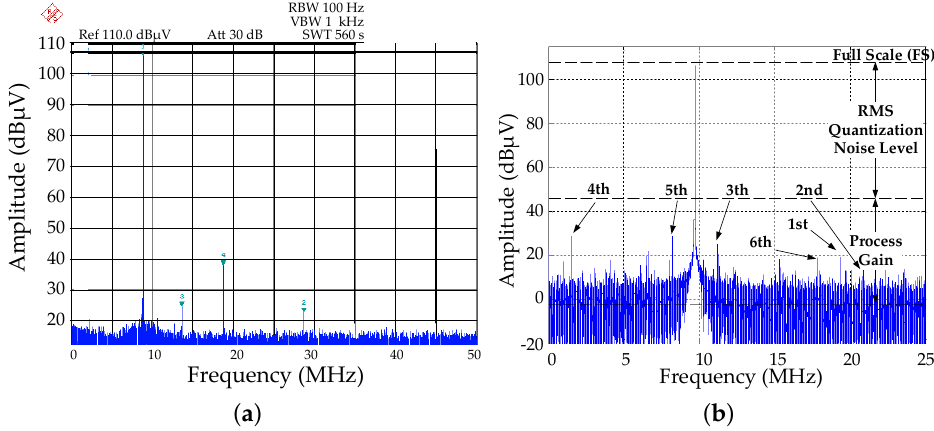
Figure 8. A single tone of 9.68 MHz injected in the IRIS to determine the ADC performance parameters: ( a ) signal generated by the HP8642B measured with a spectrum analyser; ( b ) the ADC signal provided by the chipscope in the FPGA and analysed with